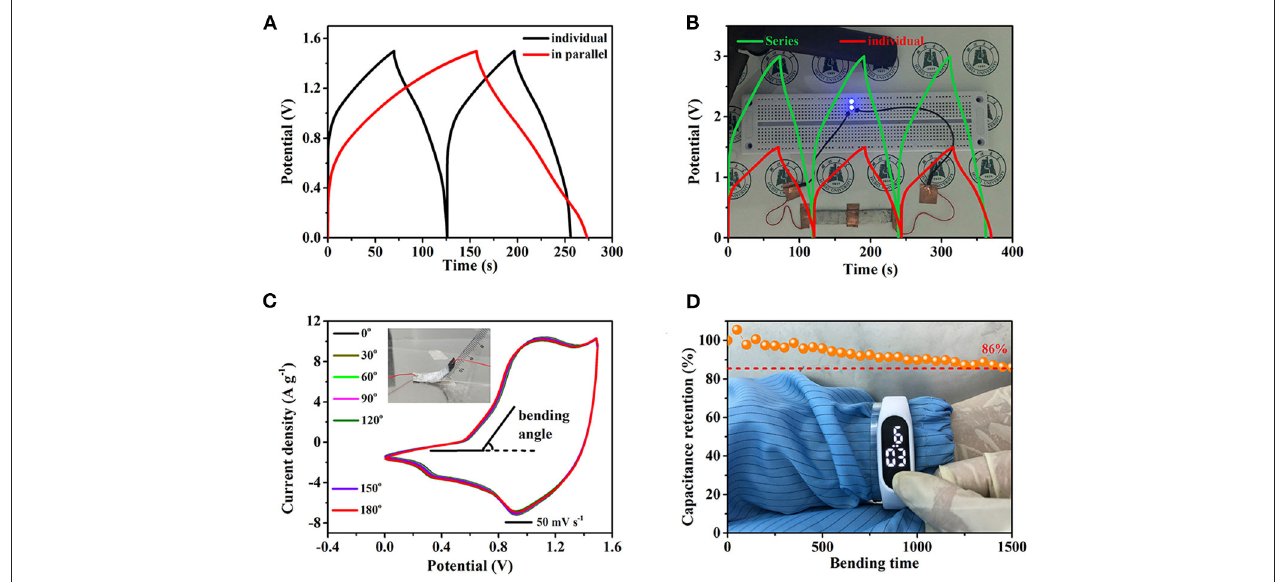
FIGURE 6 | The practical application of AFSC devices. (A) GCD curves of two AFSC devices connected in parallel. (B) GCD curves of two AFSC devices connected in series, the background is the two working blue LEDs. (C) Bending angle-tests of the AFSC, inset is the digital photograph. (D) Capacitance retention of the AFSC after 1,500 times (bending angle: 180 ◦ ), the background shows a digital watch driven by two AFSCs connected in series.